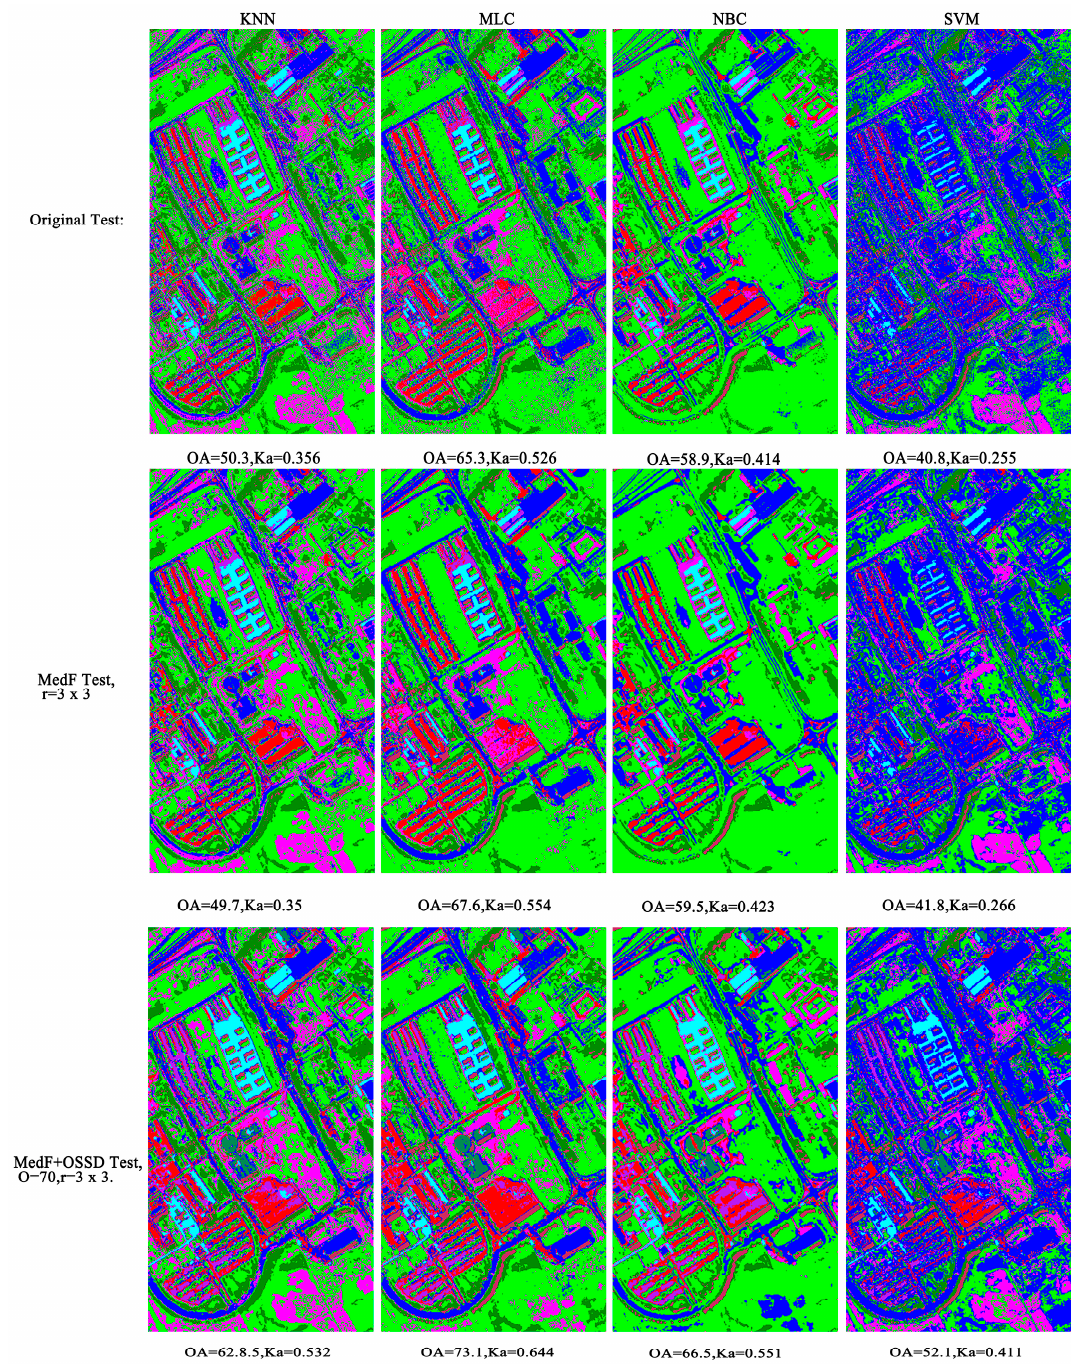
Figure 8. Classification results (Pavia University false color image); The first column , the second column , the third column and the fourth column are the classification maps of KNN, MLC, NBC, and SVM, respectively. Original test: image without any processing; MedF test: the image processed with a median filter, r = 3 × 3; OSSD-Based Test, the original image is decomposed with O = 70; OSSD + MedF test: the image is classified by the proposed system, with the parameters O = 70 and r = 3 × 3. The value of OA is given in percentage.